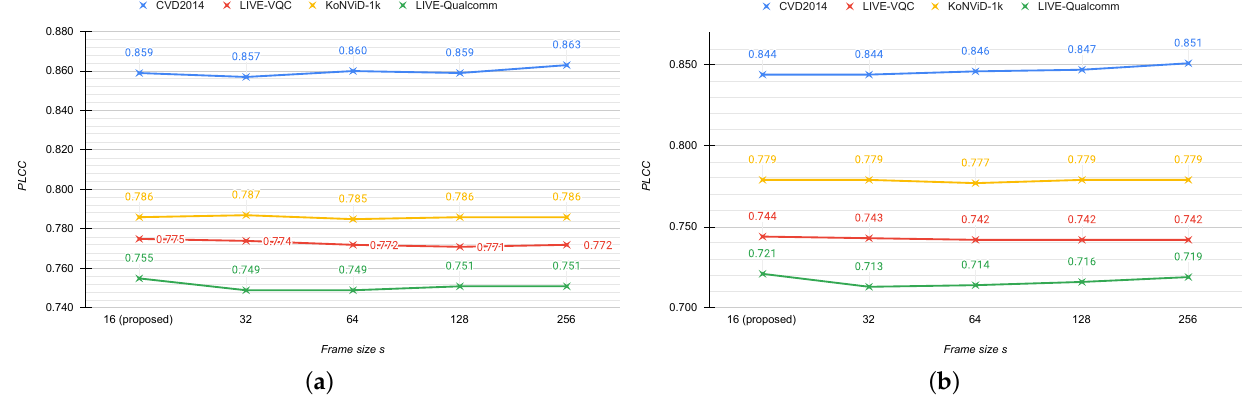
Figure 11. Mean PLCC ( a ) and SROCC ( b ) computed across 100 train–test combinations on the considered databases using different frame size ( s ) values in the proposed frame sampling